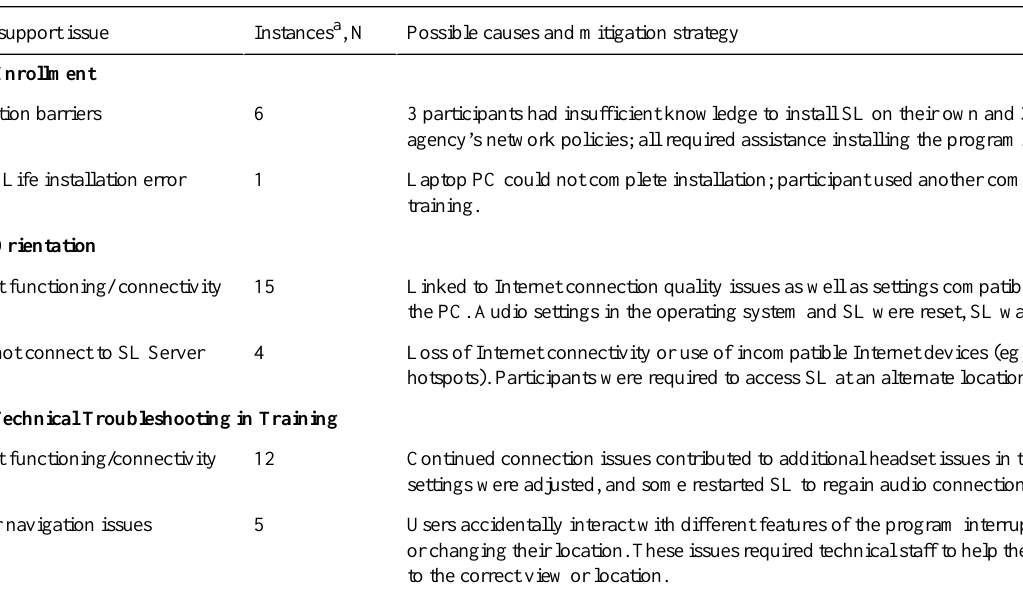
Table 2. Participant technical support and troubleshooting